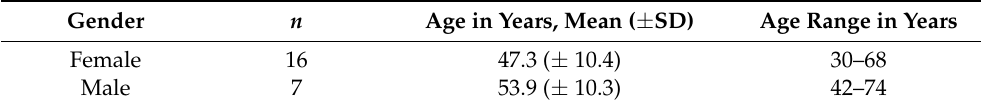
Table 3. Demographic data of the studied healthy